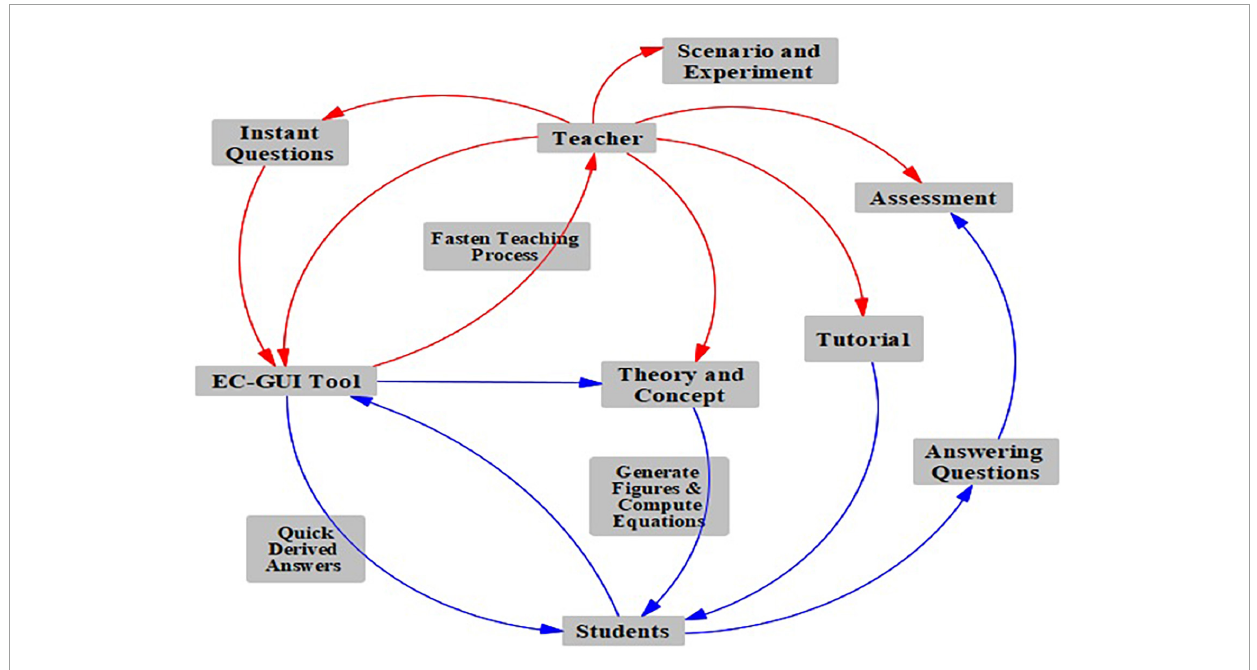
FIGURE3 The check and balance approach.